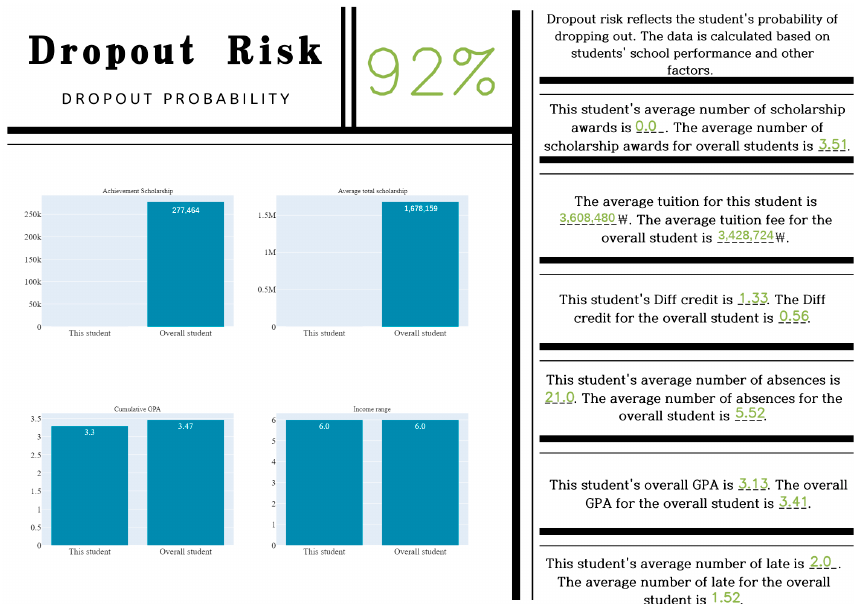
Figure 5. The Student Dropout Risk Report.